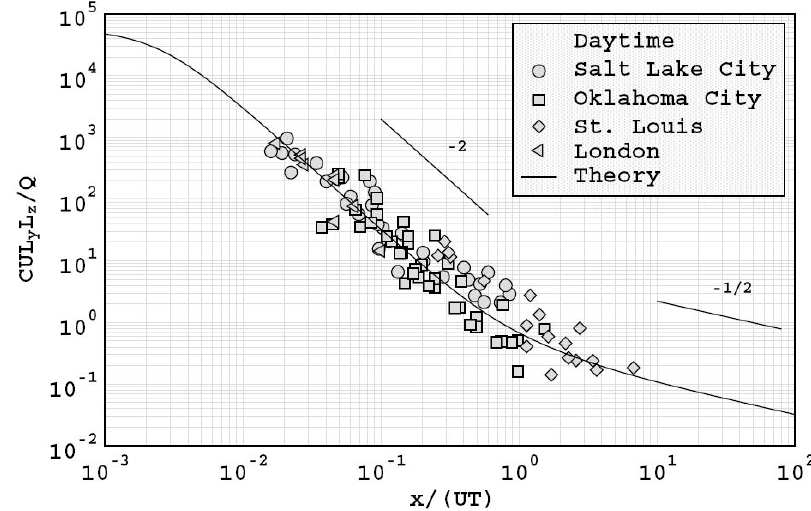
Figure 10. Comparisons between observed daytime data and analytical model predictions of Franzese and Huq [52] (2011). Reproduced with permission from [52].